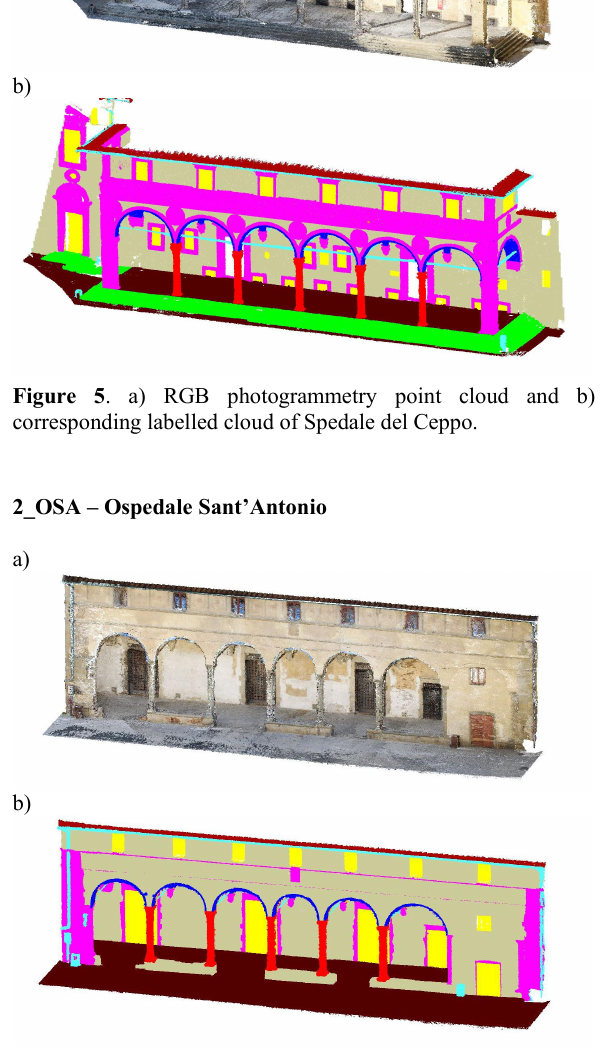
Figure 6 . a) RGB photogrammetry point cloud and b) corresponding labelled cloud of Ospedale Sant’Antonio.